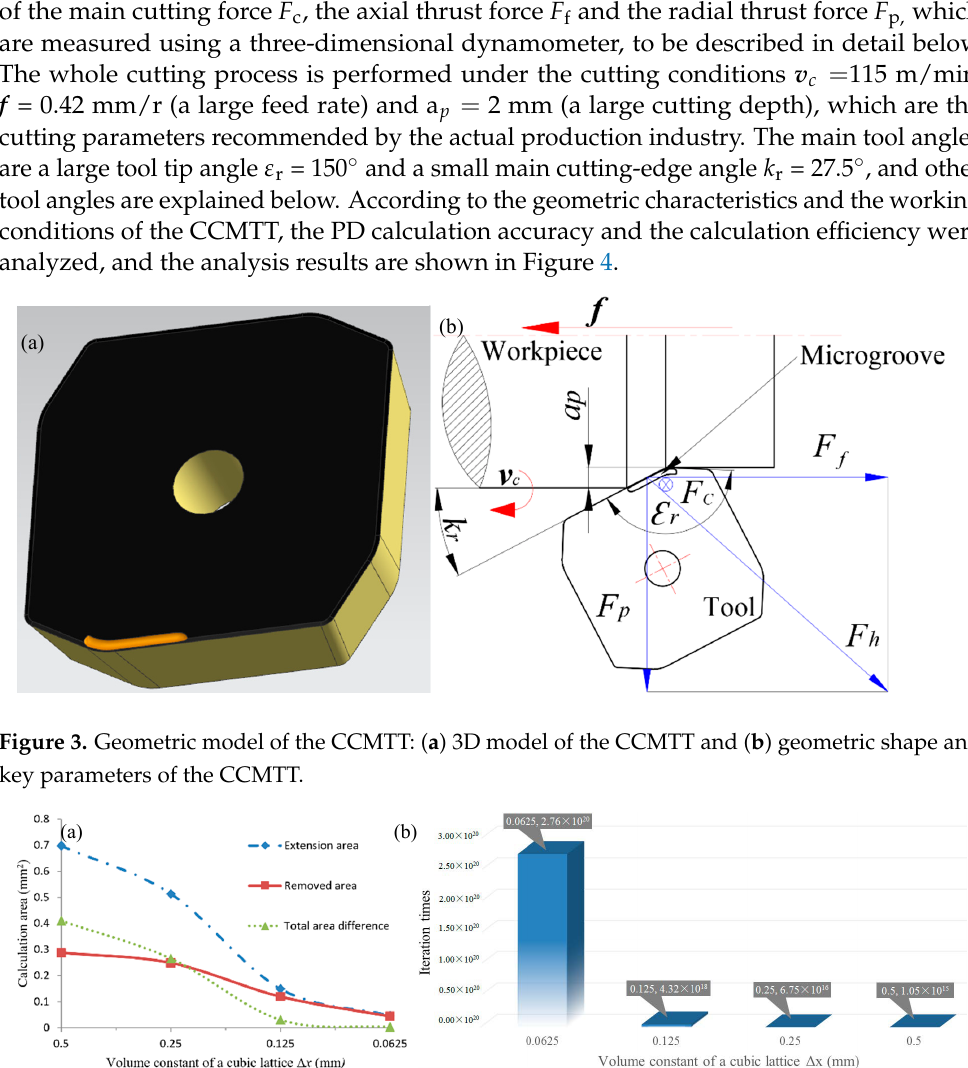
Figure 4. Analysis of calculation accuracy and efficiency: ( a ) relationship between calculation area and cubic lattice and ( b ) relationship between iteration times and cubic